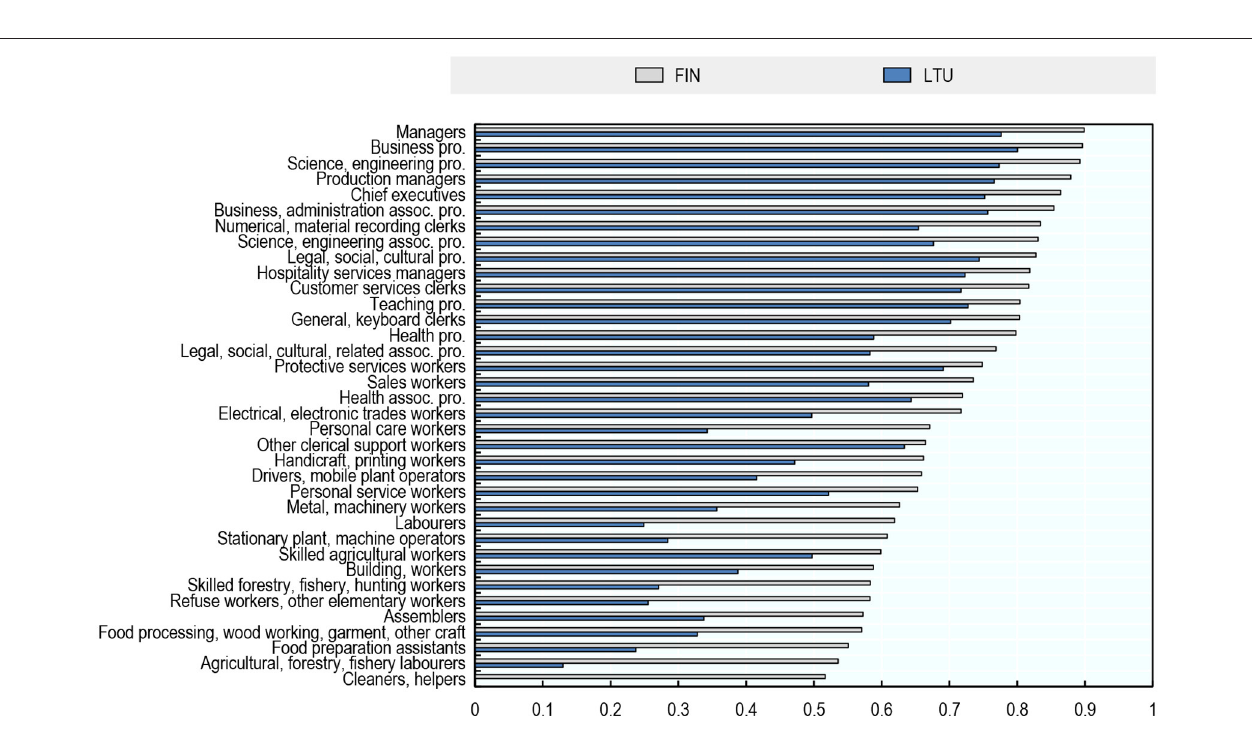
Frontiers in Artificial Intelligence |